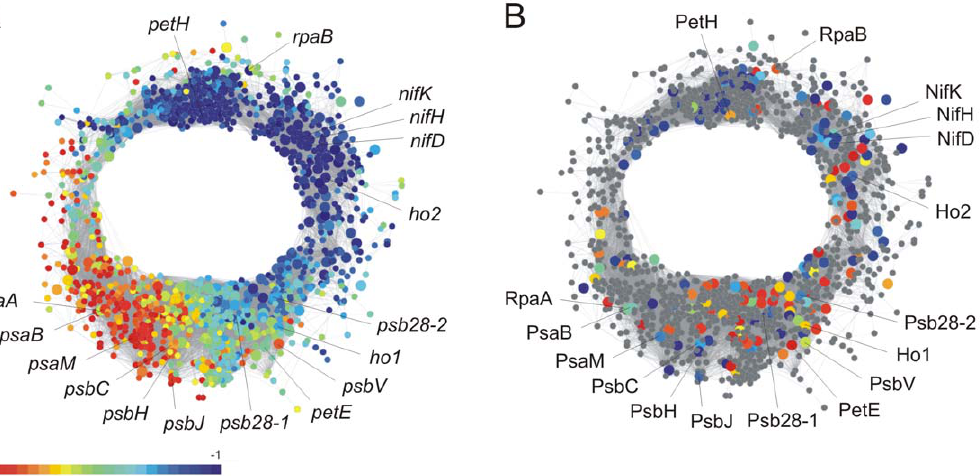
Figure 4. Integration of transcriptomic and proteomic data. (A) Co-expression network of previously obtained transcriptomic data which contains all genes with cyclic mRNA abundance that changed by at least 1.3-fold over the entire time course [5]. The network was visualized using Cytoscape version 2.5.1 [43]. Genes with Pearson correlation coefficients $ 0.9 are connected and each node corresponds to one gene. The genes are colored according to their relative mRNA abundance at time point L5 (five hours in the light cycle). (B) All genes in the co-expression network from panel A for which cyclically expressed proteins were detected are colored according to the relative protein abundance levels at time point L5. Genes without corresponding cyclic proteins are shown in grey . Other time points are shown in Figure S5.